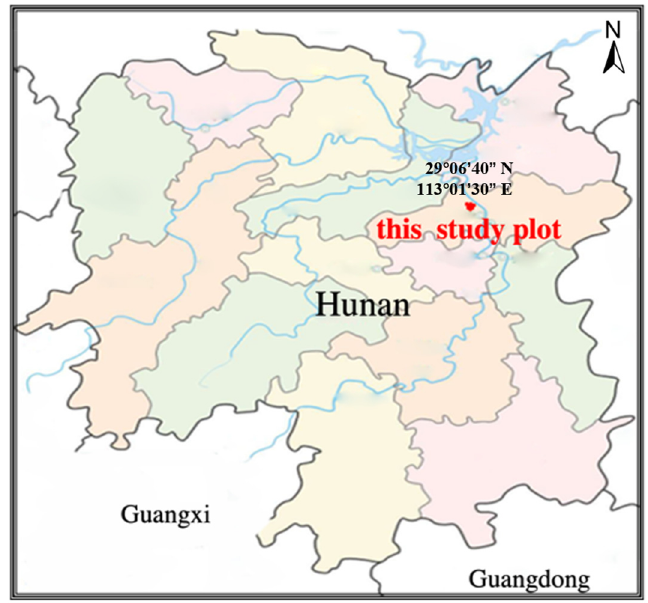
Figure 1. Location map of this study plot.